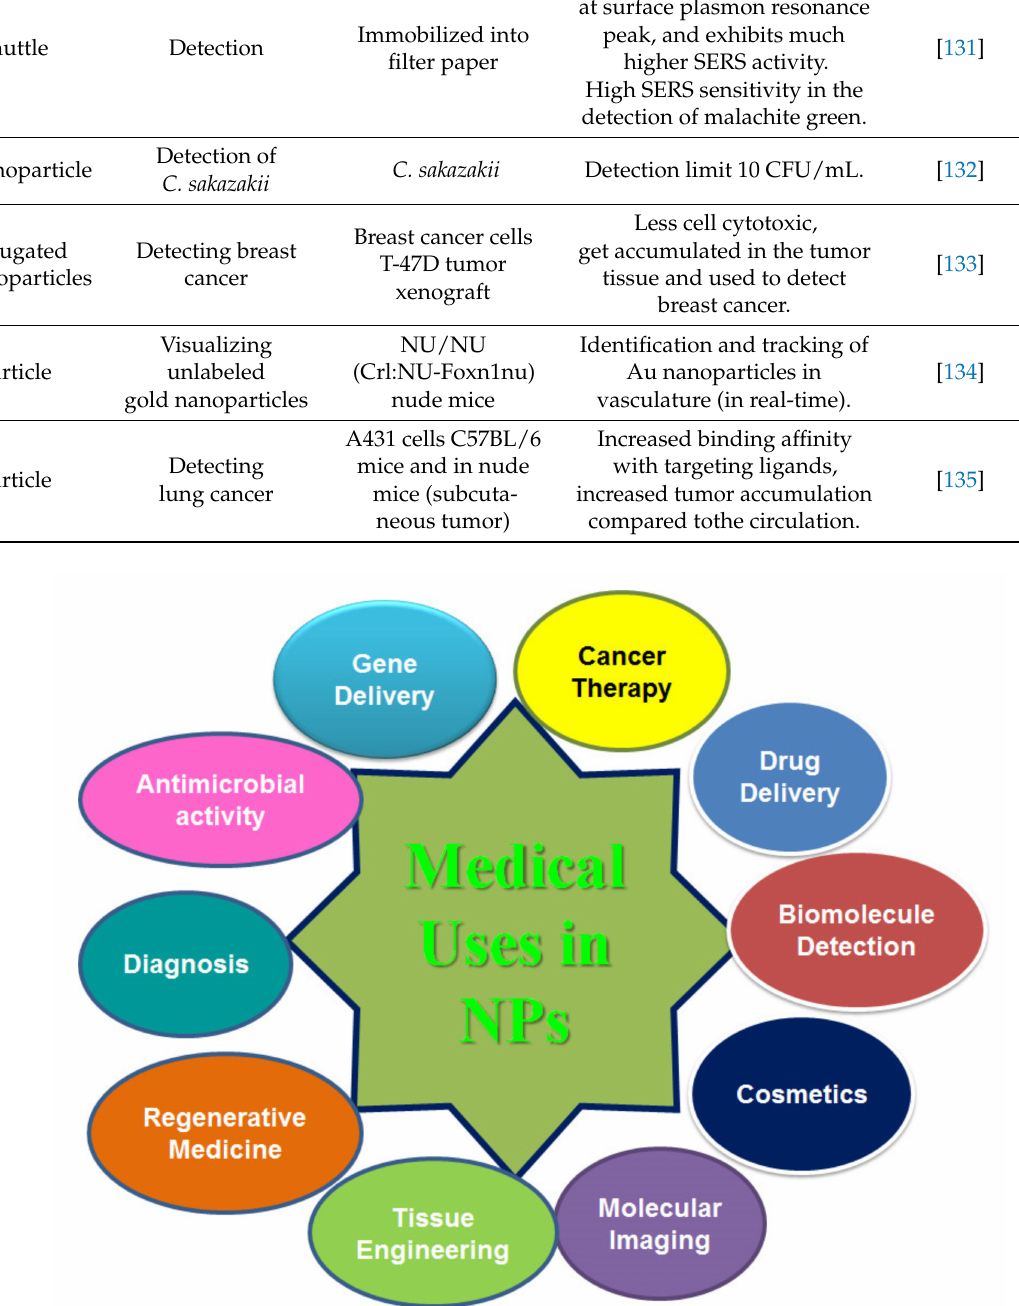
Figure 4. Broad spectrum biomedical application of